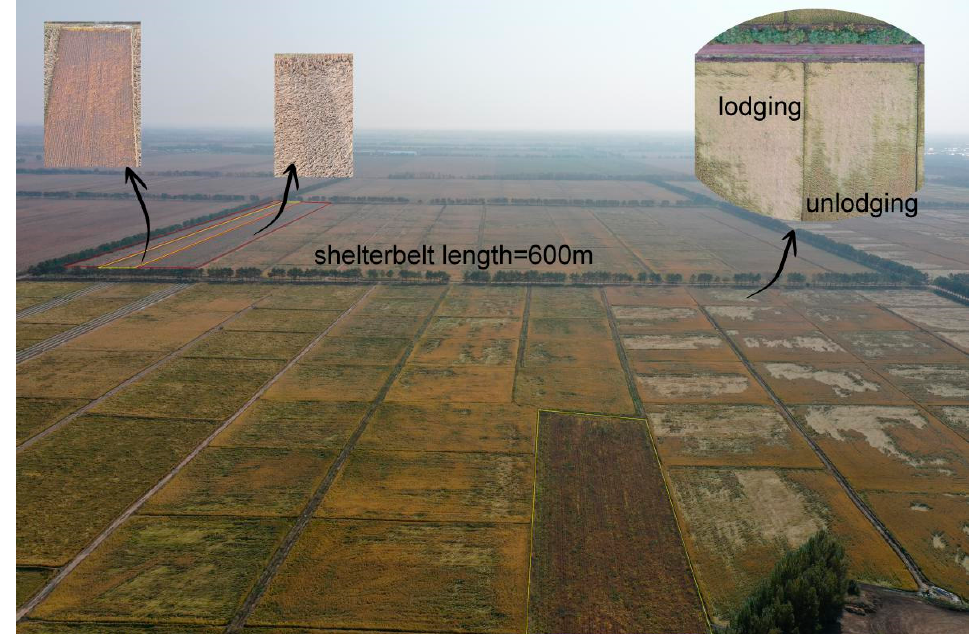
Figure 1. Crop lodging after Typhoon Haishen adjacent to a 600 m shelterbelt. The inset shows the lodging areas in white, and unlodging in yellow and green.